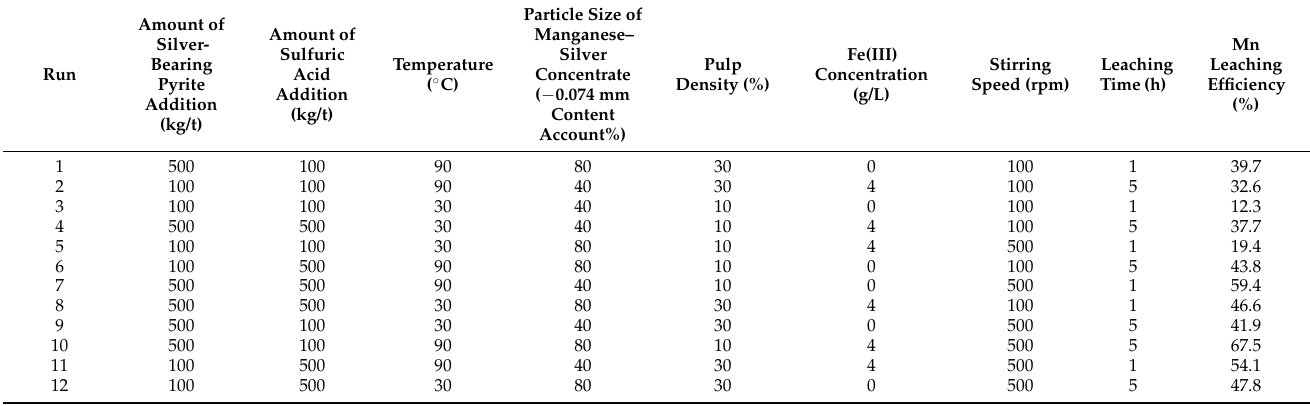
Table 3. Twelve-trial Plackett–Burman design matrix for eight parameters with actual values along with observed Mn leaching